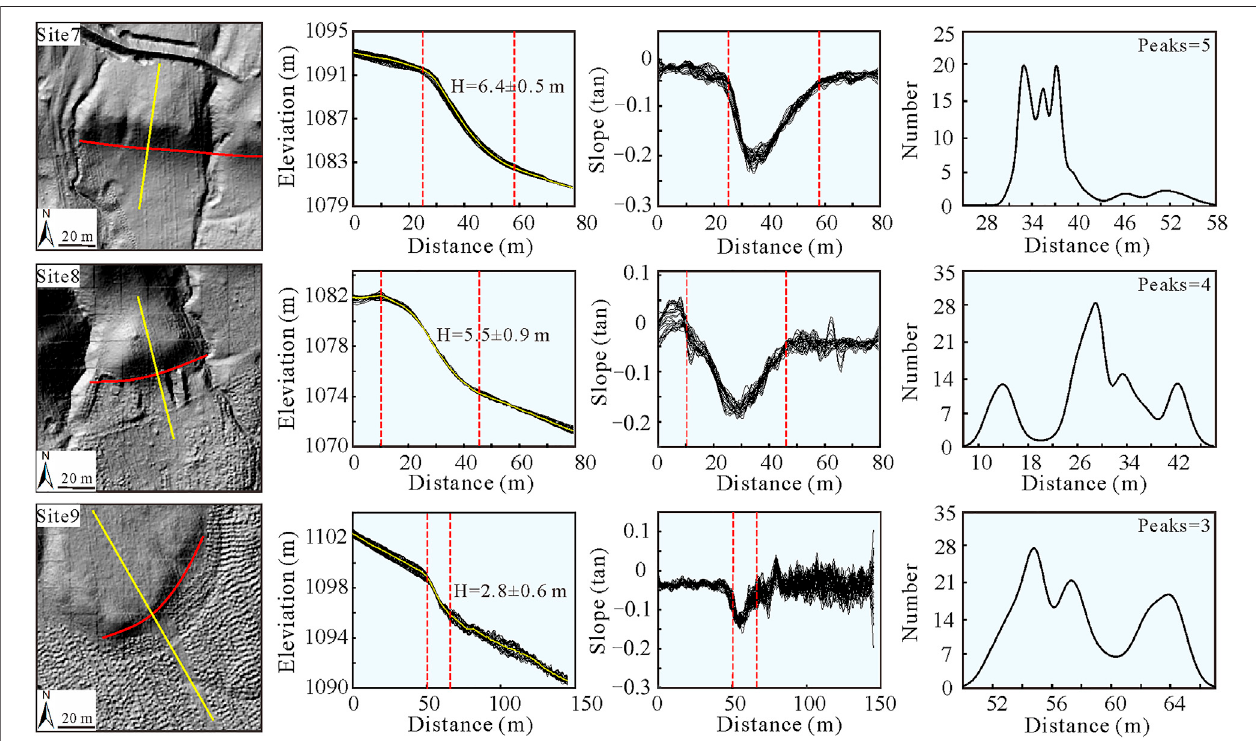
FIGURE 12 | Identi fi cation of slope breaks in the scarp pro fi les at three sites on the Heshunzhuang-Baotou segment. The fi rst column displays the LiDAR-DEM at each site, and the red and yellow lines represent the fault trace and extracted topographic pro fi le, respectively. In the second column, the black lines indicate the extractedswath topographicpro fi les (40 topographicpro fi les at aninterval of 0.5 m), and the yellow line denotes theaveraged topographicpro fi le,whilethered dashed linesmarkthescarprange.Inthethirdcolumn,theblacklinesindicatethecalculatedswathslopepro fi les.Inthefourthcolumn,theblacklinedenotestheprobability density distribution of the positions of all searched slope breaks in the swath slope pro fi les, and the number of peaks represent the number of slope breaks, that is the number of surface-rupturing events.